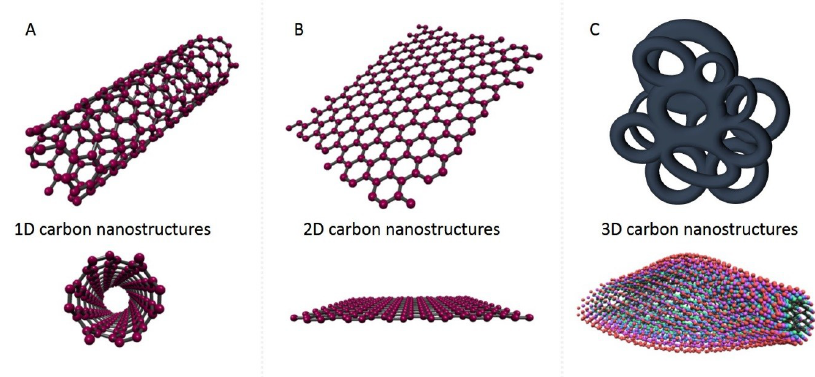
Figure 1. Illustration of the main carbon nanostructures described in this review. ( A ) 1D carbon nanostructures represented by carbon nanotubes. ( B ) 2D carbon nanostructures represented by graphene. ( C ) 3D carbon nanostructure represented by graphene foam, which is an intricate three-dimensional network of